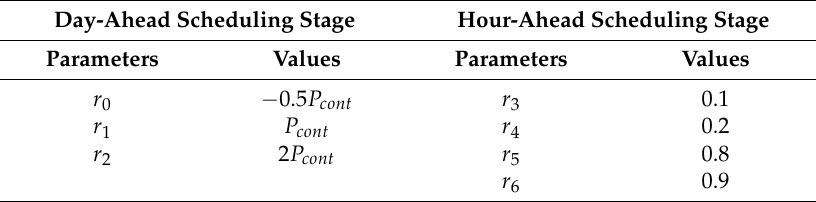
Figure A1. Piecewise linear approximation of penalty functions. ( a ) max (0, k t ) function; ( b ) { − min (0, s t ) + max (0, l t )}. Table A1. Parameter values for the piecewise linearization of the penalty functions.